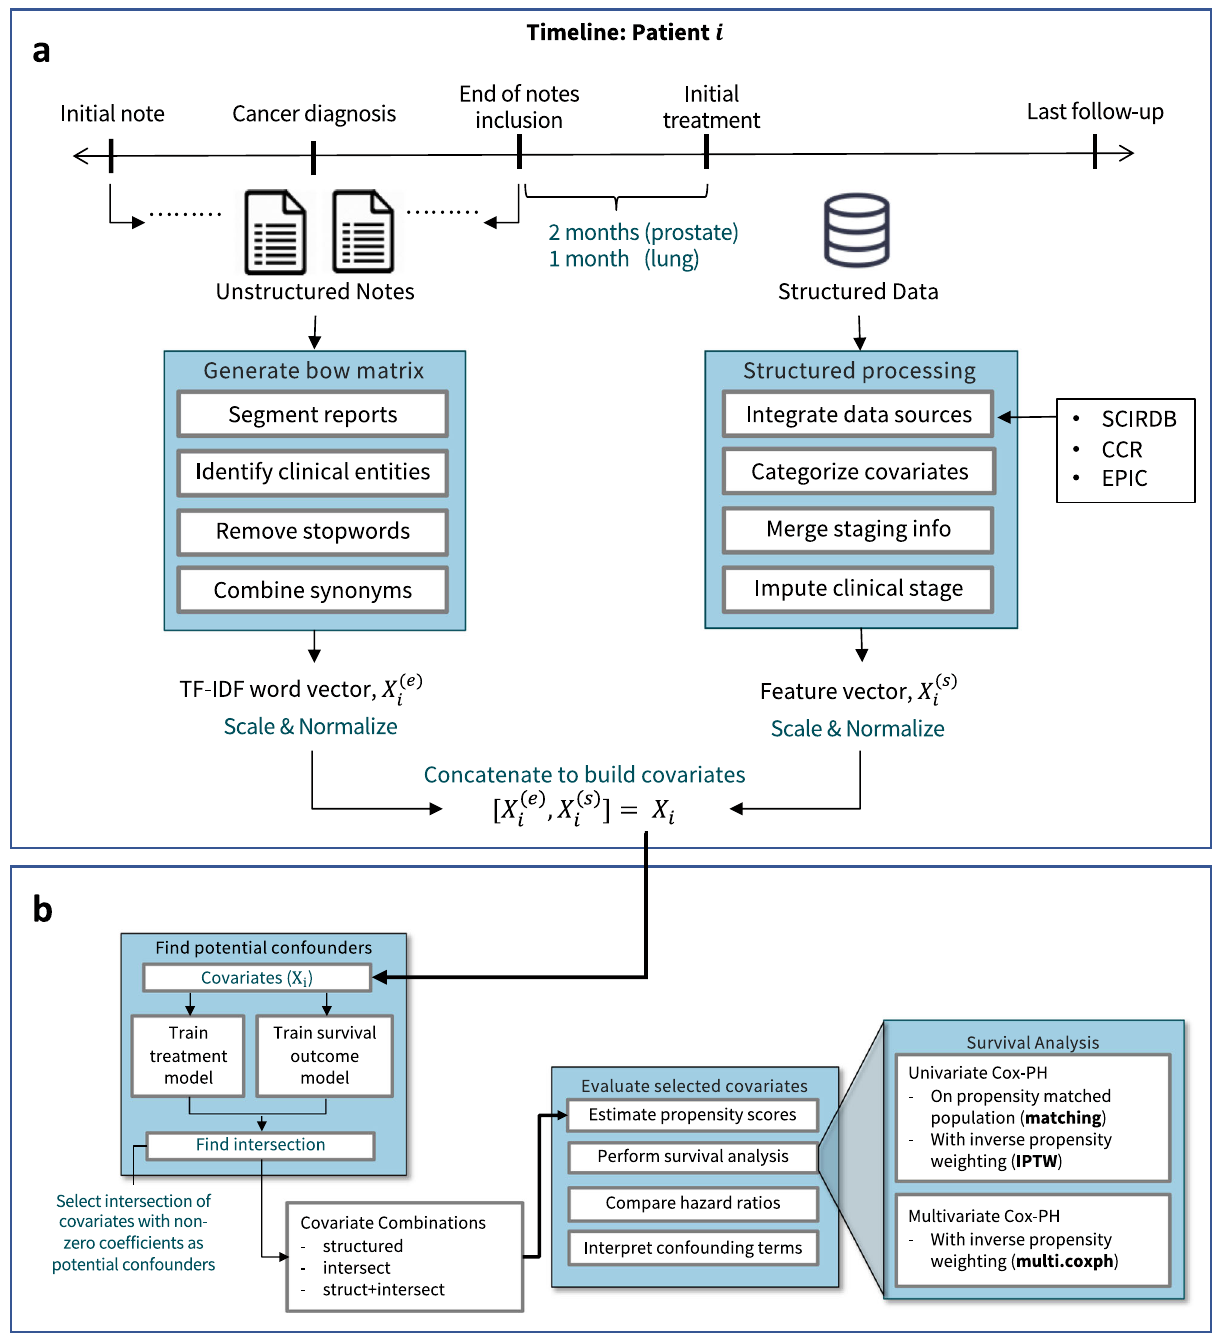
Fig. 1 Pictorial overview for uncovering potential confounders. a shows the data processing done for each patient. We preprocess and concatenate the structured and unstructured covariates before applying our method. For the data sources, we compile data from the Stanford Cancer Institute Research Database (SCIRDB), the California Cancer Registry (CCR), and the Epic System. We present the timeline for patient i with both structured ( X ð s Þ i ) and unstructured ( X ð e Þ i ) features X i . b shows the work fl ow for identifying how potential confounders affect survival analysis for each treatment group. We uncover covariates that are predictive of both the treatment and outcome as potential confounders. We then perform survival analysis on different combinations of the selected